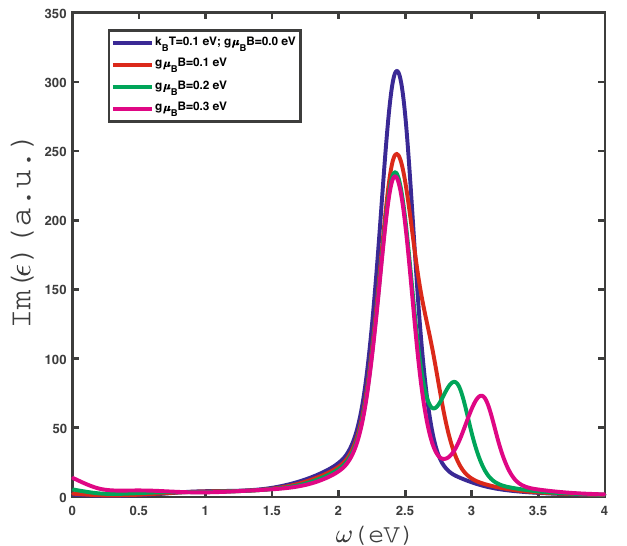
Figure 2. Optical absorption, Im (ǫ) , of undoped MoS 2 layer as a function of photon frequency in the absence 0 , for different values of applied magnetic field g µ ε y of homogenous strain , i.e. ε x = = 0.1 k B T =